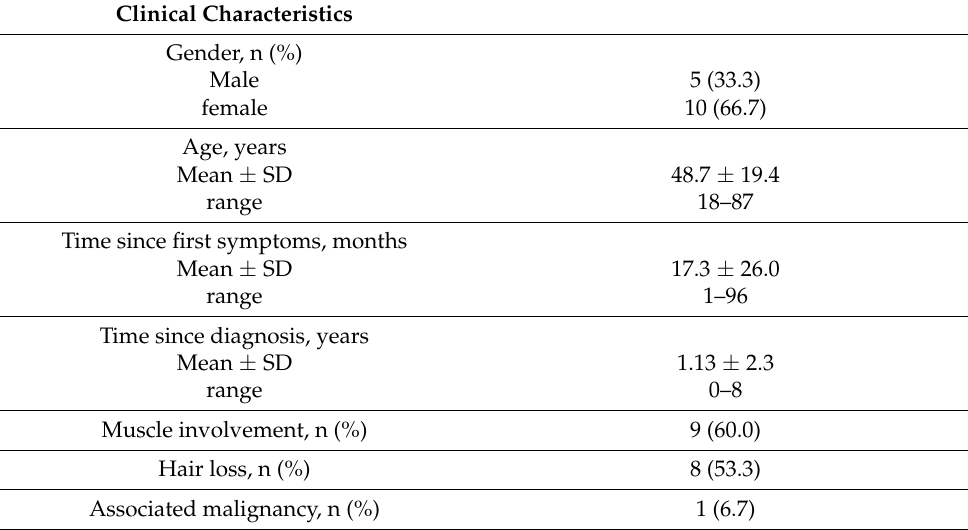
Table 1. Clinical characteristics of study participants (SD–standard